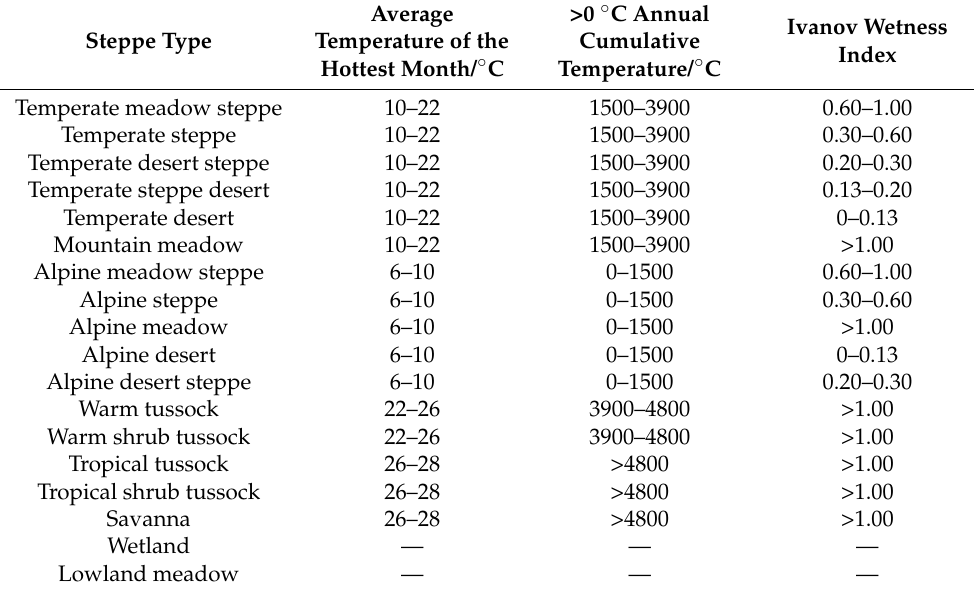
Table 1. Meteorological classification indicators for grassland